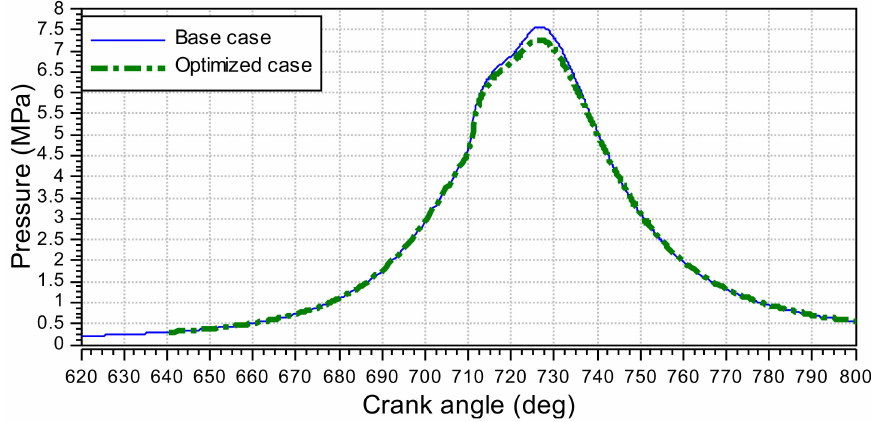
Figure 23. The pressure curve for the optimal three-stage injection strategy compared to base case. A little bit later combustion with an increasing of CD can be seen in Figure 24. The pilot ROHR is lower than the base case, because the pilot fuel mass injection is lower.